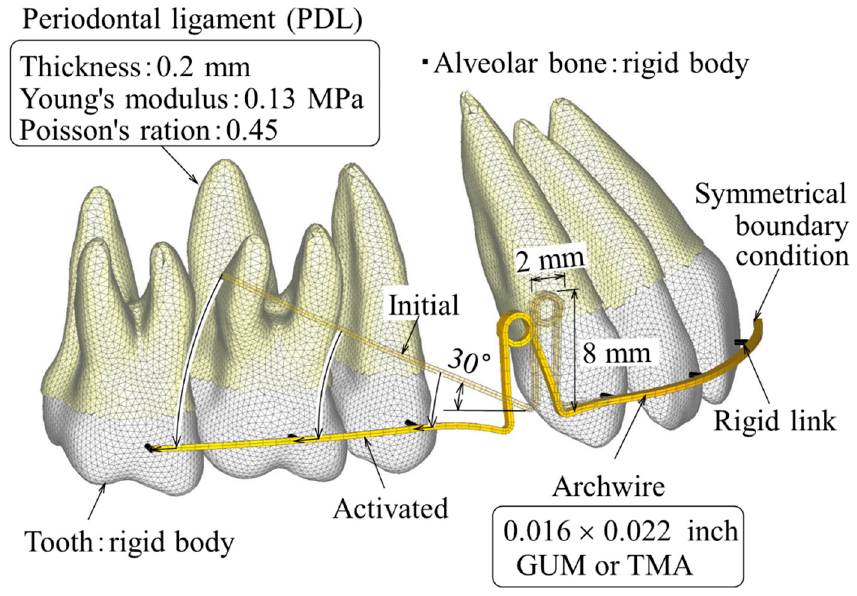
Figure 1. Finite element model for simulating extraction space closure using double loop spring.